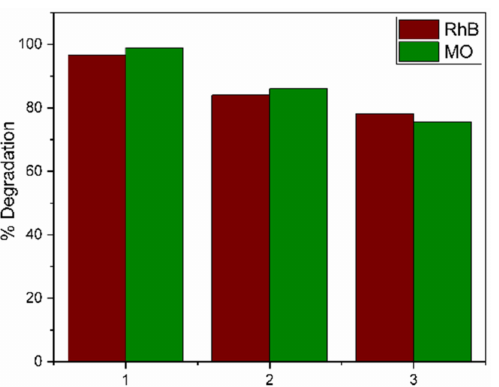
Figure 14. Photocatalytic degradations by the TZ-1 sample after 3 cycles for RhB and